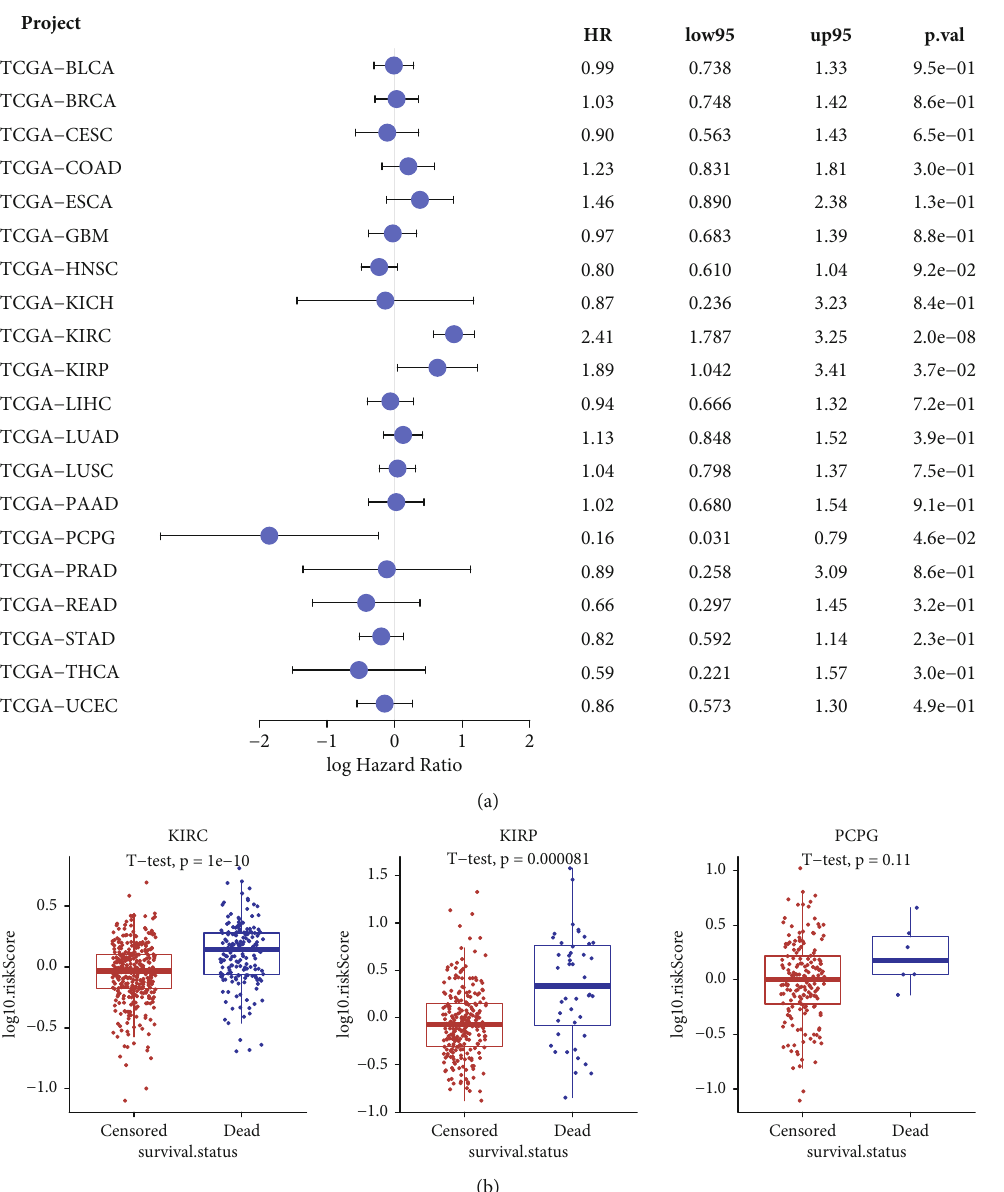
Figure 3: Prognostic analysis of the cGAS-STING sensor across human cancers. (a) Univariate Cox regression analysis was performed to determine the prognostic values of the cGAS-STING sensor. (b) Expression pattern of cGAS-STING in KIRC, KIRP, and PCPG with di ff erent survival status (censored or death). BLCA: bladder urothelial carcinoma; BRCA: breast invasive carcinoma; CESC: cervical squamous cell carcinoma and endocervical adenocarcinoma; COAD: colon adenocarcinoma; ESCA: esophageal carcinoma; GBM: glioblastoma multiforme; HNSC: head and neck squamous cell carcinoma; KICH: kidney chromophobe; KIRC: kidney renal clear cell carcinoma; KIRP: kidney renal papillary cell carcinoma; LIHC: liver hepatocellular carcinoma; LUAD: lung adenocarcinoma; LUSC: lung squamous cell carcinoma; PAAD: pancreatic adenocarcinoma; PCPG: pheochromocytoma and paraganglioma; PRAD: prostate adenocarcinoma; READ: rectum adenocarcinoma; STAD: stomach adenocarcinoma; THCA: thyroid carcinoma; UCEC: uterine corpus endometrial carcinoma; HR: hazard ratio. ∗ P < 0 : 05 ; ∗∗ P < 0 : 01 ; ∗∗∗ P < 0 : 001 ; ∗∗∗∗ P < 0 : 0001